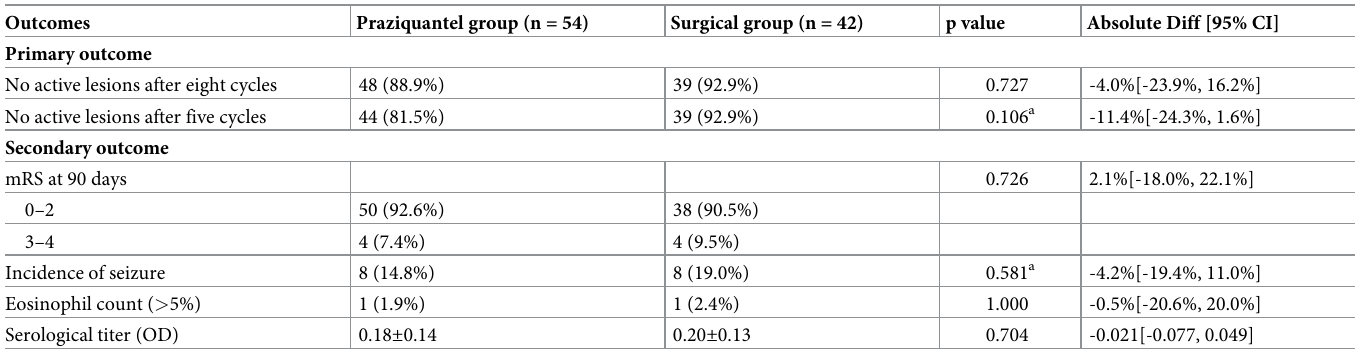
Table 2. Results of the primary and secondary efficacy outcomes between the praziquantel and surgical groups.